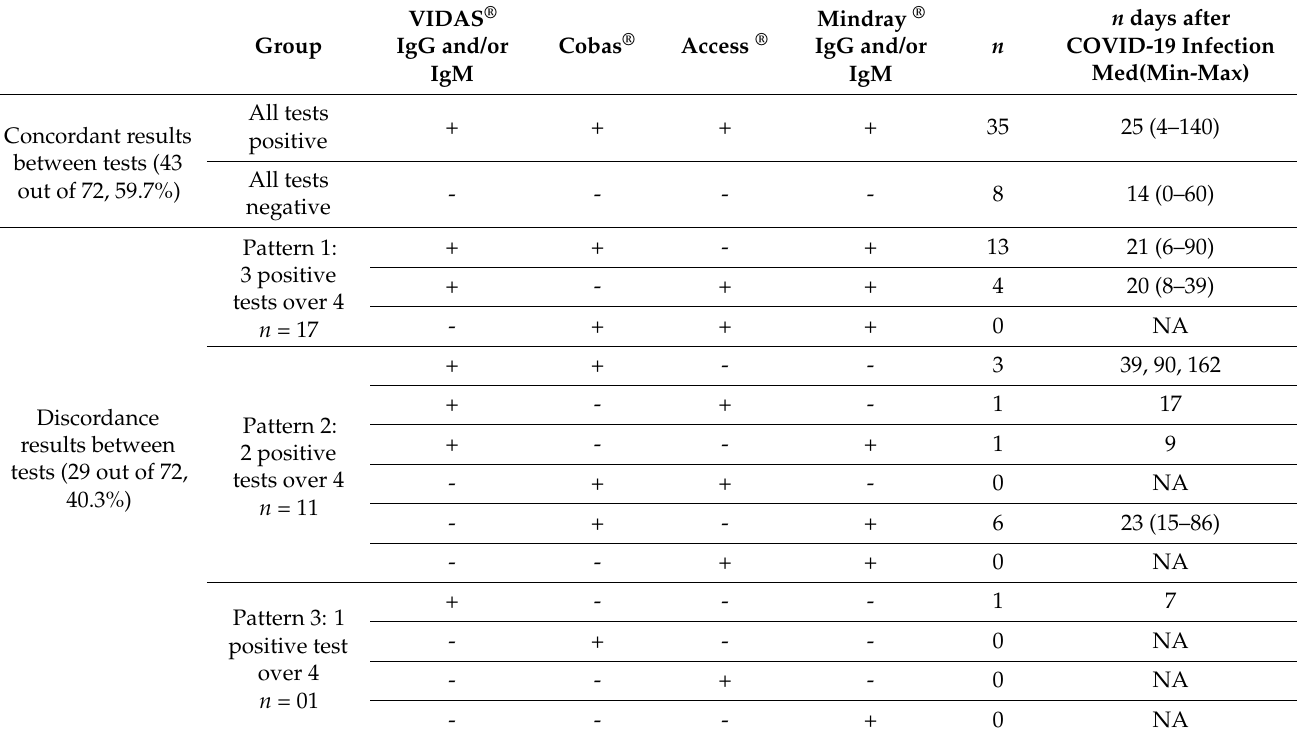
Table 3. Concordance and discordance results obtained by the four evaluated test results for the positive panel ( n =